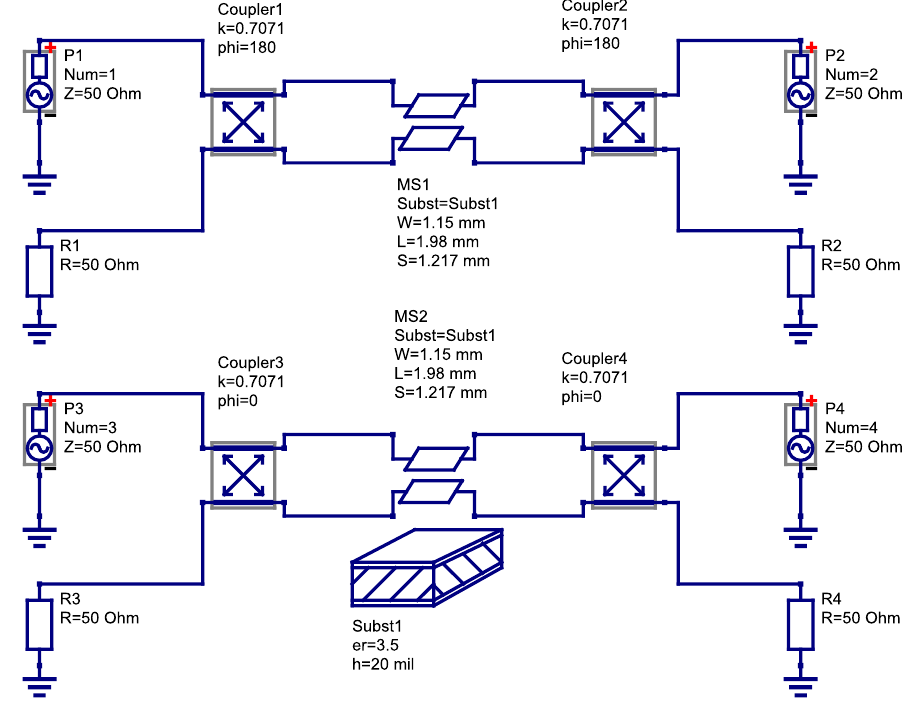
Figure 6. The circuit simulation of the coupler’s even - and odd-mode electrical lengths.